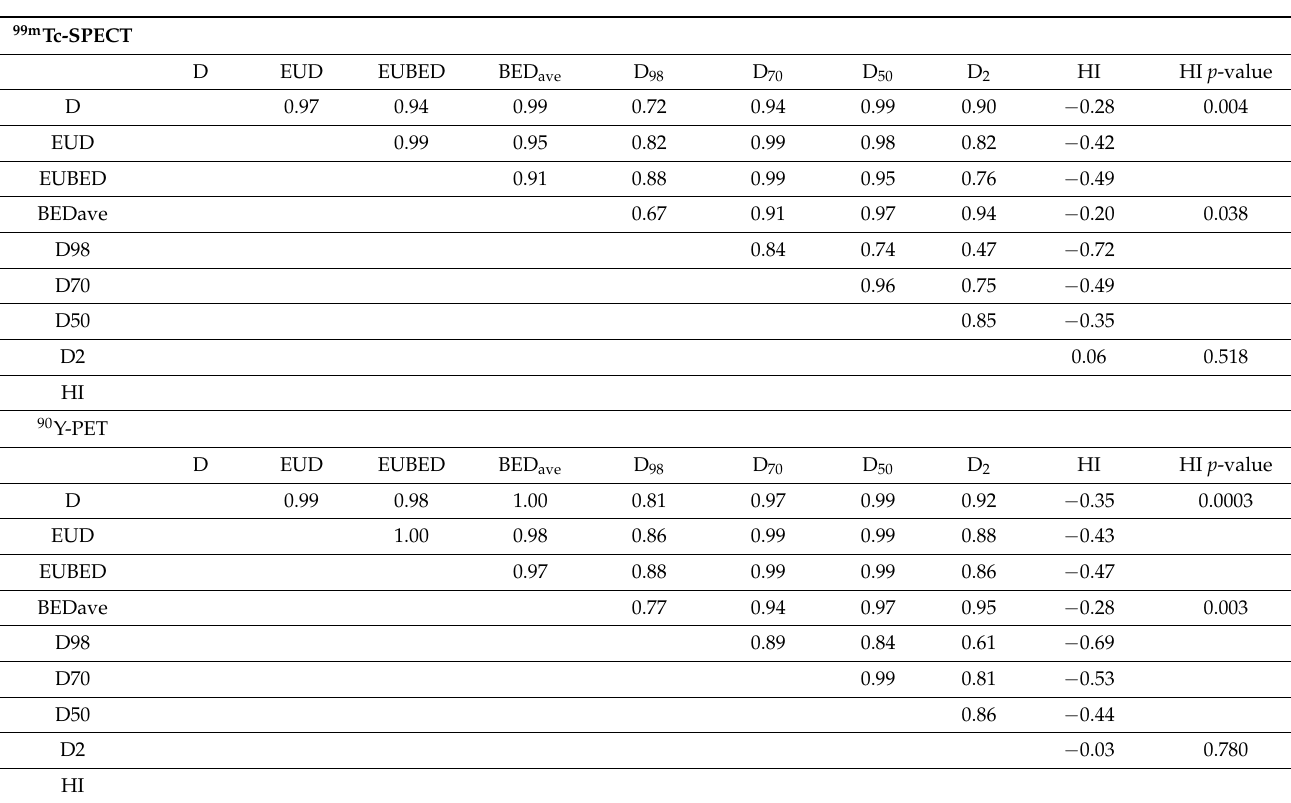
Table 9. Spearman correlation coefficients r among pairs of variables. All p -values were < 0.0001 except those for HI, which are reported in the last